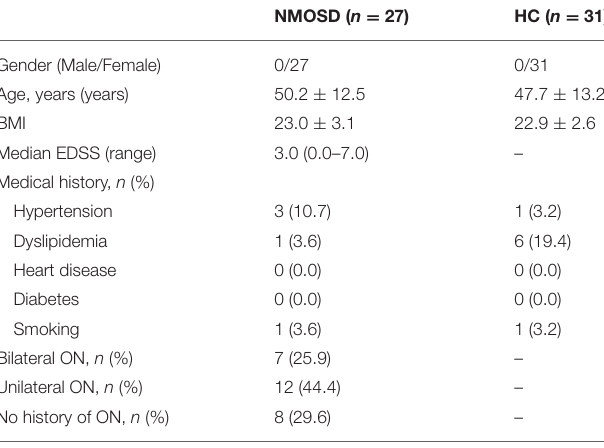
TABLE 1 | Participant demographics and clinical summary.